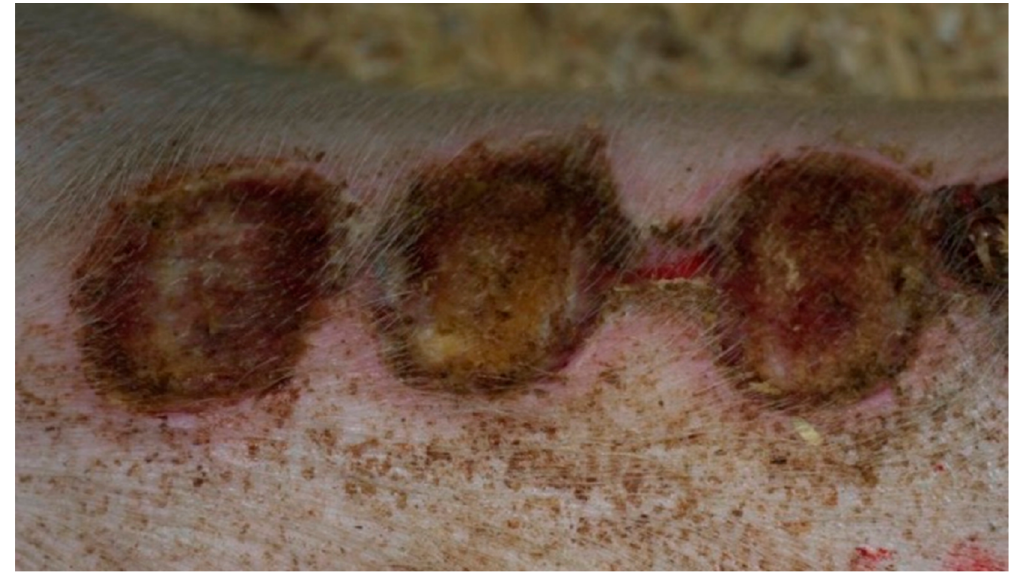
Figure 3. Group D3—burn wound treated with the ointment with 1% propolis and 1% nanosilver on day 5.